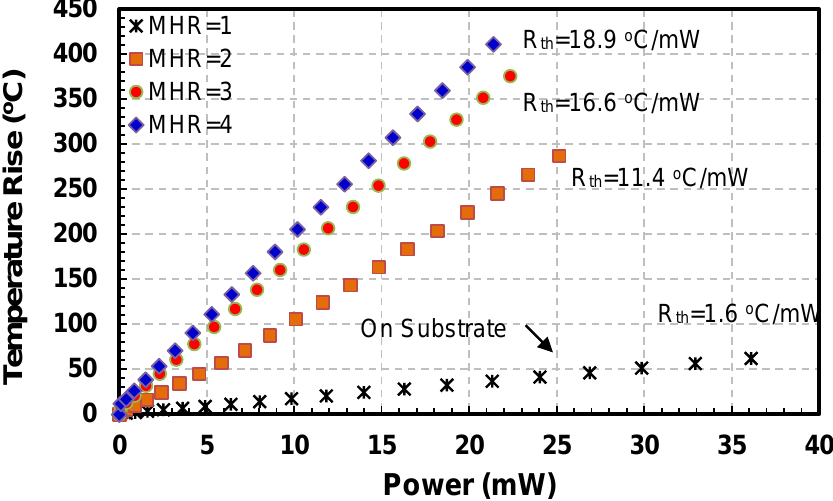
Figure 11. Power versus temperature rise curves of sensors FS2, FS4, FS6 and FS8 having circular membranes: For the FS2 sensor with MHR = 1 (on partially etched substrate), there is a negligible temperature rise in the sensor. There is a greater temperature rise between sensors with MHR = 2 and 3, which reduces significantly for the sensor having MHR =4.